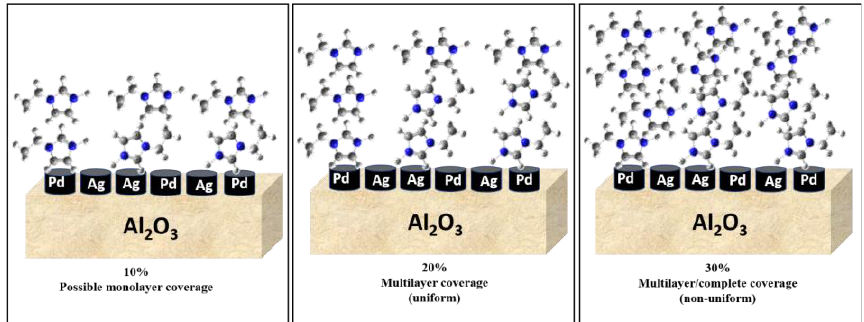
Figure 2. Different possible coverages associated with different EIM loadings.